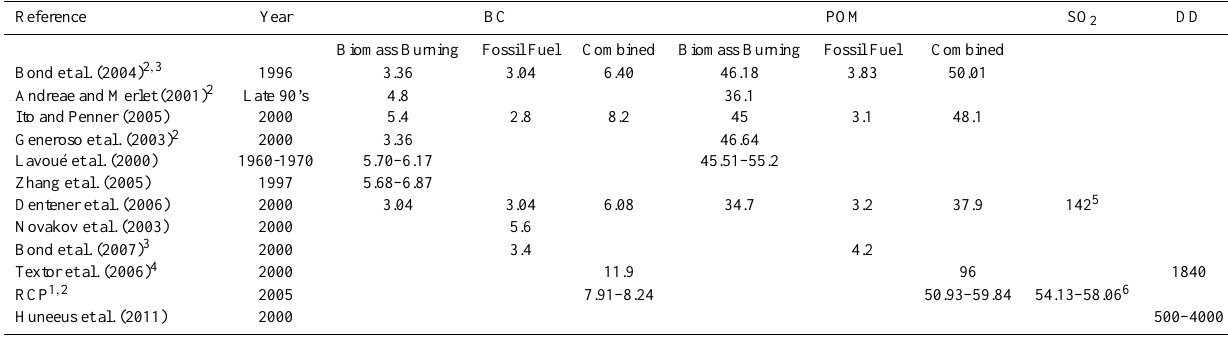
Table 1. Emission fluxes or flux ranges [Tgyr − 1 ] for different aerosol species in the literature.